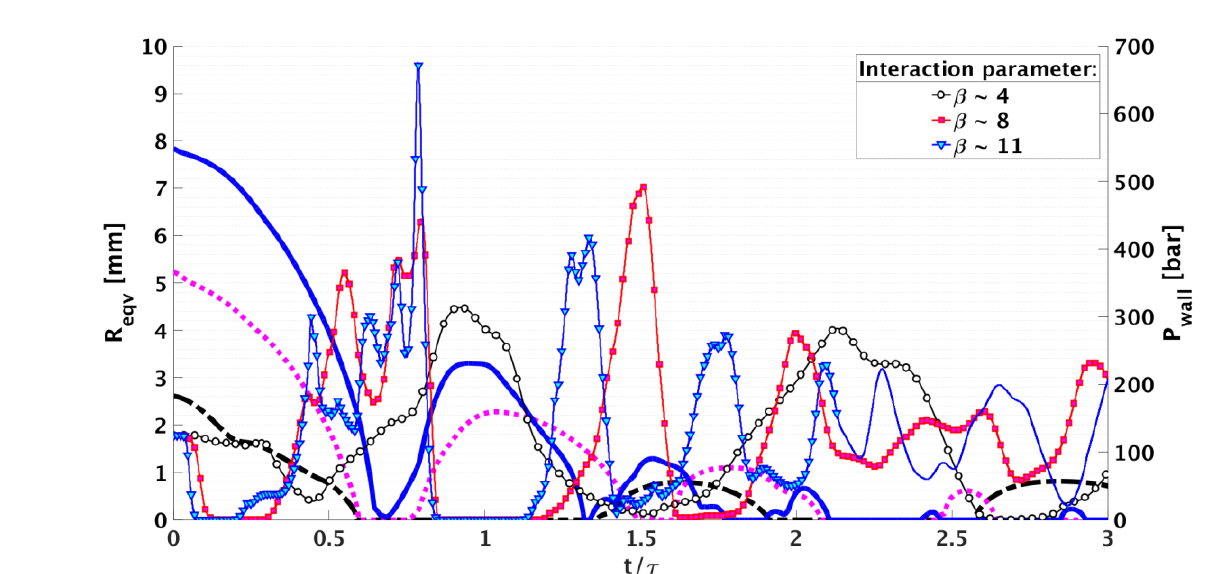
Fig. 4: Setup I: Thick line – equivalent bubble radius evolution; thin line - pressure recorded by the wall transducer; both against dimensionless time scaled with Rayleigh time for equivalent bubble